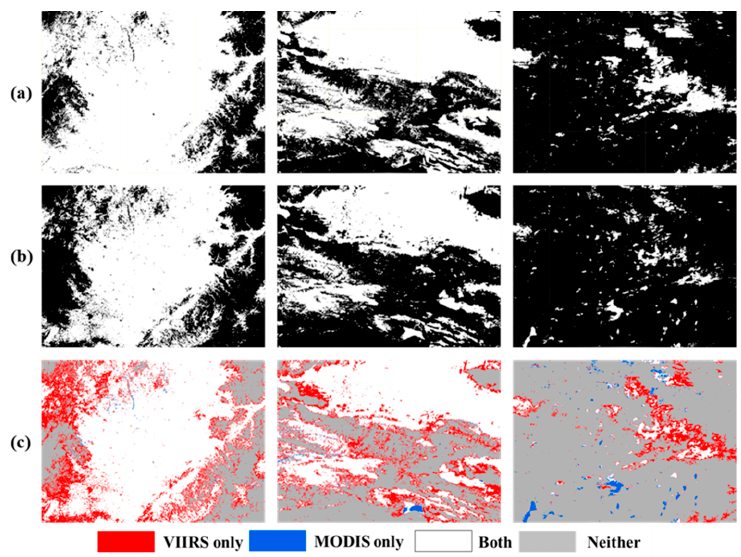
Figure 9. The snow/ice flag distribution and difference in VIIRS and MODIS. The snow/ice flag is represented in white in ( a ) VIIRS and ( b ) MODIS; ( c ) difference map in snow/ice flags with legend shown below. The red color shows snow/ice flags in VIIRS only, blue shows those in MODIS only, white represents those in both VIIRS and MODIS and gray shows those in neither. The test regions and the DOY are shown from left to right: NE (2020002), NW (2020038) and QT (2020047).